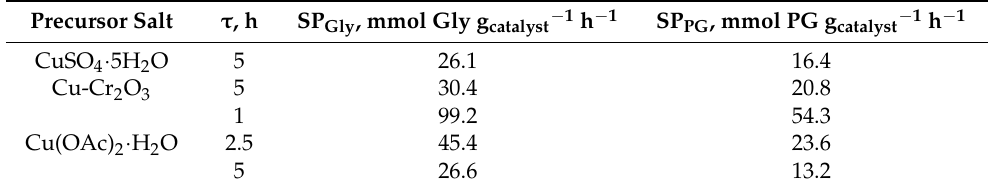
Table 6. The SP values for the various copper catalysts in the glycerol hydrogenolysis. T = 220 ◦ C, p(H 2 ) = 3.0 MPa, KOH/Cu = 5.8, Gly/Cu = 50